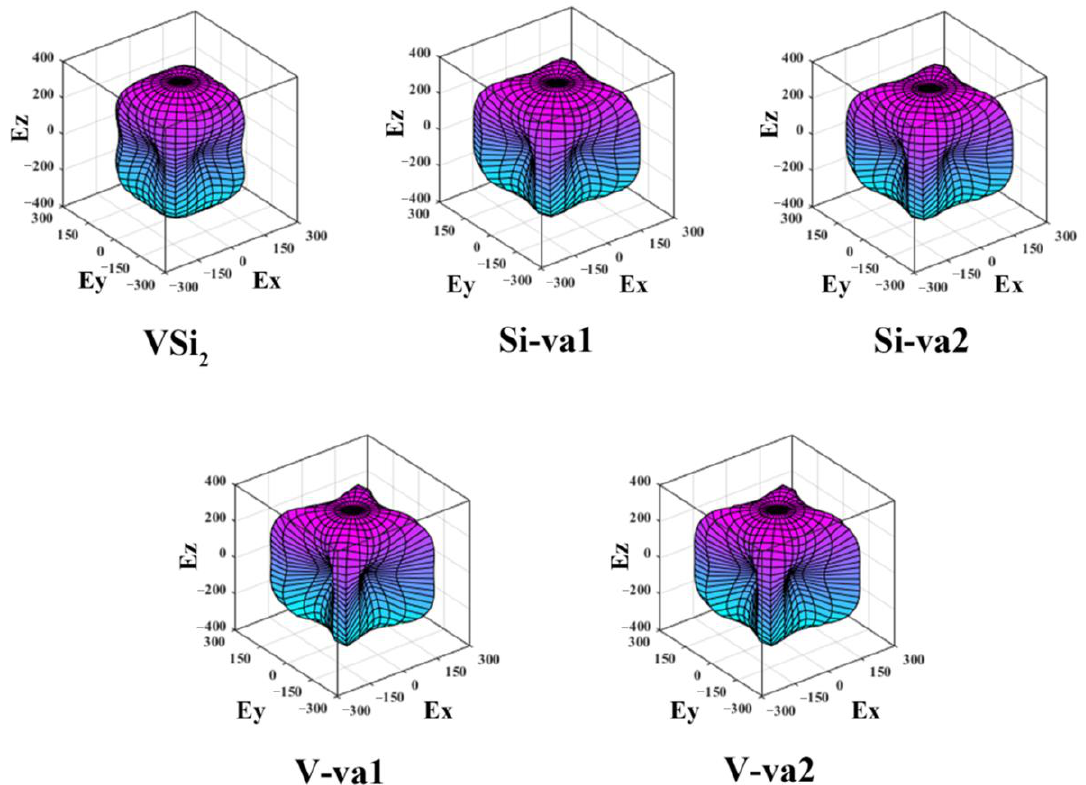
Figure 4. Surface constructions of Young ’ s moduli of C11 b -VSi 2 .